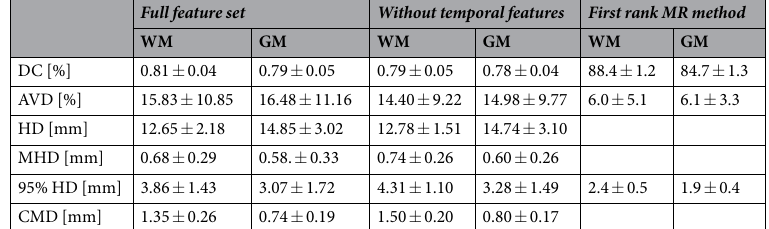
Table 1. Quantitative results averaged over all folds of the cross validation, and results from the MR segmentation method ranked first in a challenge 24 .